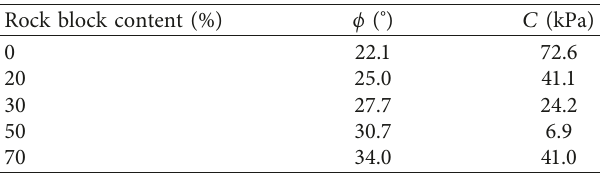
Table 4: Strength index of different rock contents according to the Mohr–Coulomb criterion.